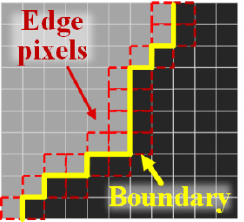
Figure 4. Schematic for the edge in the discrete image.